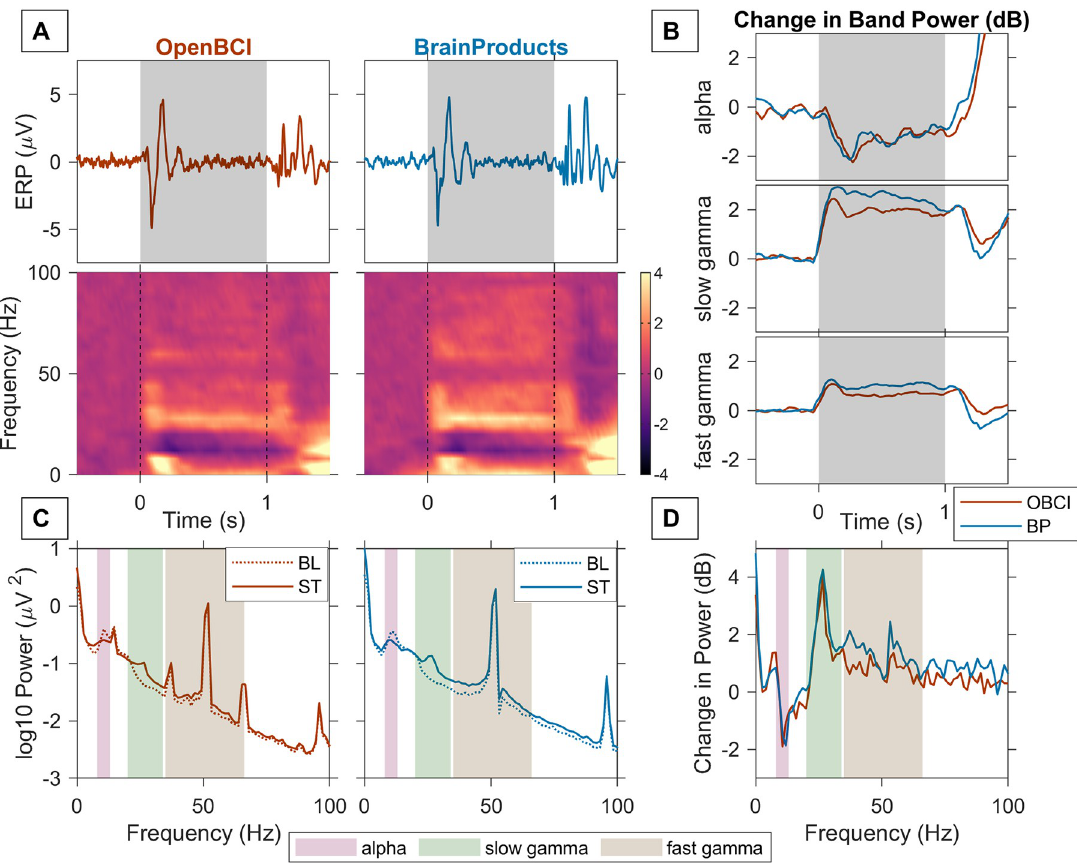
Fig 2. Stimulus induced gamma response in an example subject. A) Trial averaged EEG trace or ERP ( first row ) and time frequency spectrograms of change in power from baseline with time ( second row ). Vertical grey bars indicate stimulus duration (1 second). B) Change in Power (dB) from baseline as a function of time in alpha (8–13 Hz, first row ), slow gamma (20–34 Hz, second row ) and fast gamma (35–66 Hz, third row ) bands recorded using OpenBCI ( red trace ) and Brain Products ( blue trace ). C) PSD for stimulus ( solid line ) and baseline ( dotted line ) averaged across 5 bipolar electrodes for OpenBCI ( left column ) and BrainProducts ( right column ). D) Change in power (dB) from baseline in stimulus period recorded using OpenBCI ( red trace ) and Brain Products ( blue trace